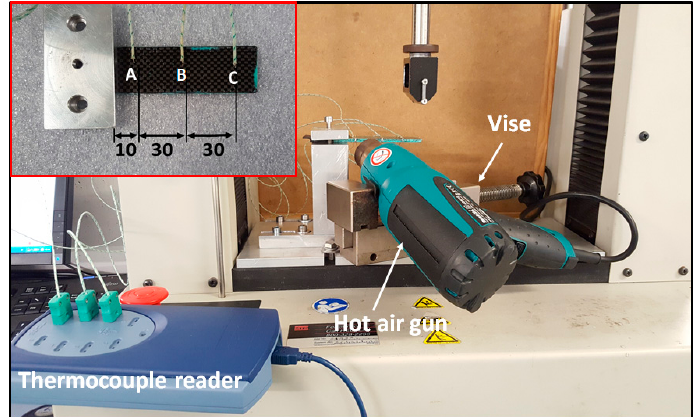
Figure 3. Temperature calibration for SMP testing.